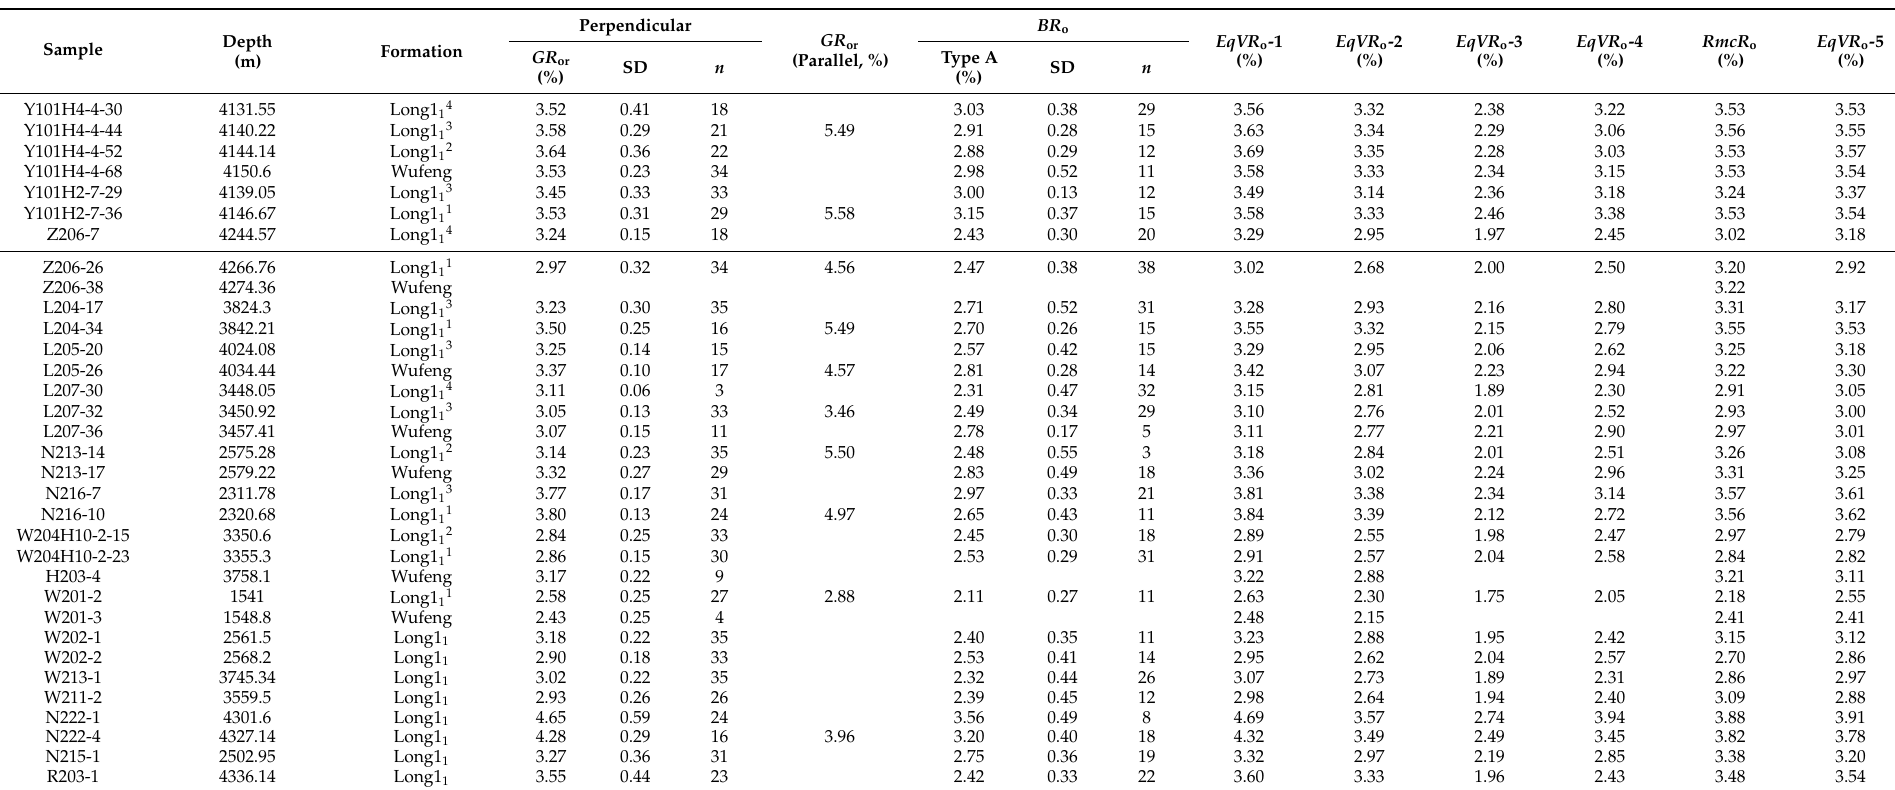
Table 1. Random reflectance and equivalent vitrinite reflectance for graptolites and solid bitumen in the Wufeng–Longmaxi Formations from southern Sichuan